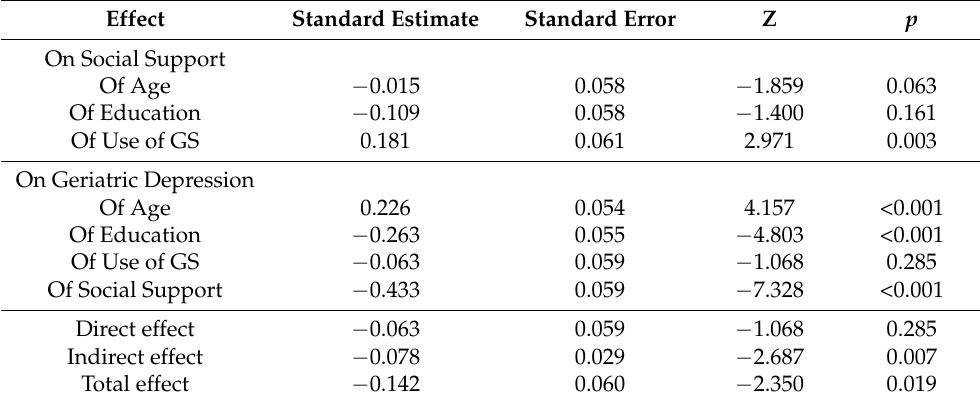
Table 2. Standardized effects, standard errors, z scores, and p values for each outcome variable, direct, indirect, and total effect of use of GS on geriatric